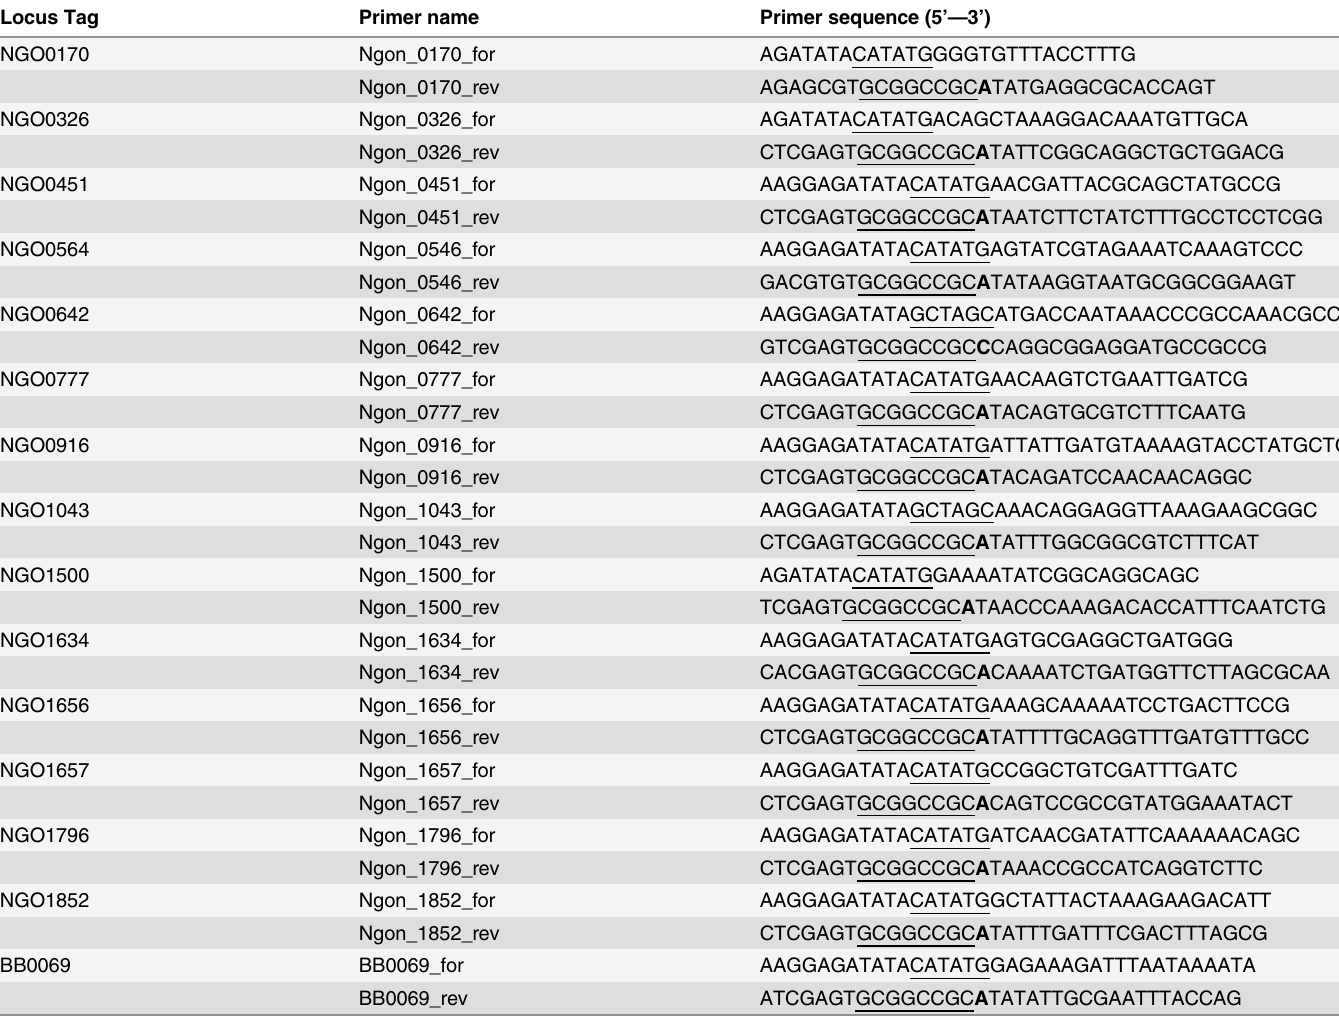
Table 2. Primers utilized for full-length gene